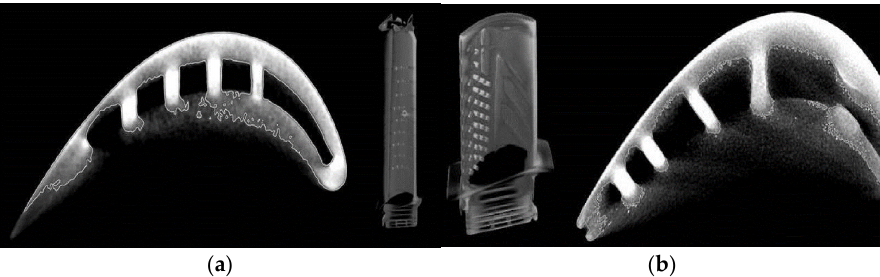
Figure 6. The shape of the LPT blade ( a ) and the HPT blade ( b ), with visible cooling channels, obtained by the computer-based micro-tomography CT.